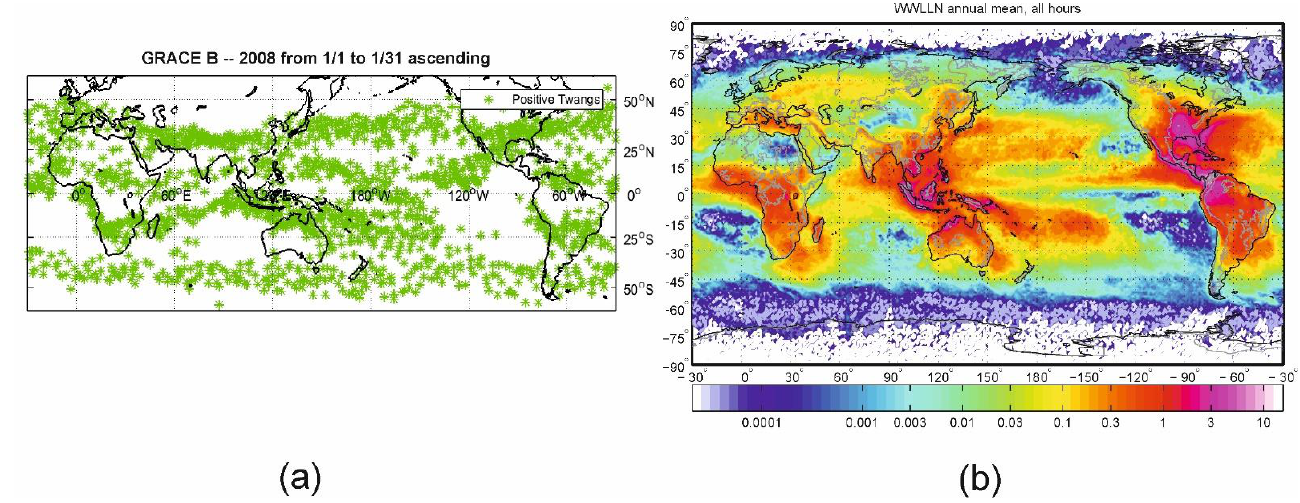
Figure 12. A comparison between the geographical occurrence of high-amplitude positive twangs ( a ) and the annual mean occurrence of lightning strikes ( b ) detected by the World Wide Lightning Location Network (WWLLN, right, [30] © American Meteorological Society; used with permission). In the region between 25° north and south, the dominant areas where twangs and lightning occur are South and Middle America, Africa, and Indonesia. Gaps of twangs and lightning are visible at the same locations, between South America and −130°, between Australia and Africa, and between Africa and South America. The main difference is the band of twangs within 40–50° north and 40–50° south, where the magnetic field is favorable for the coupling of sferics into the ionosphere.